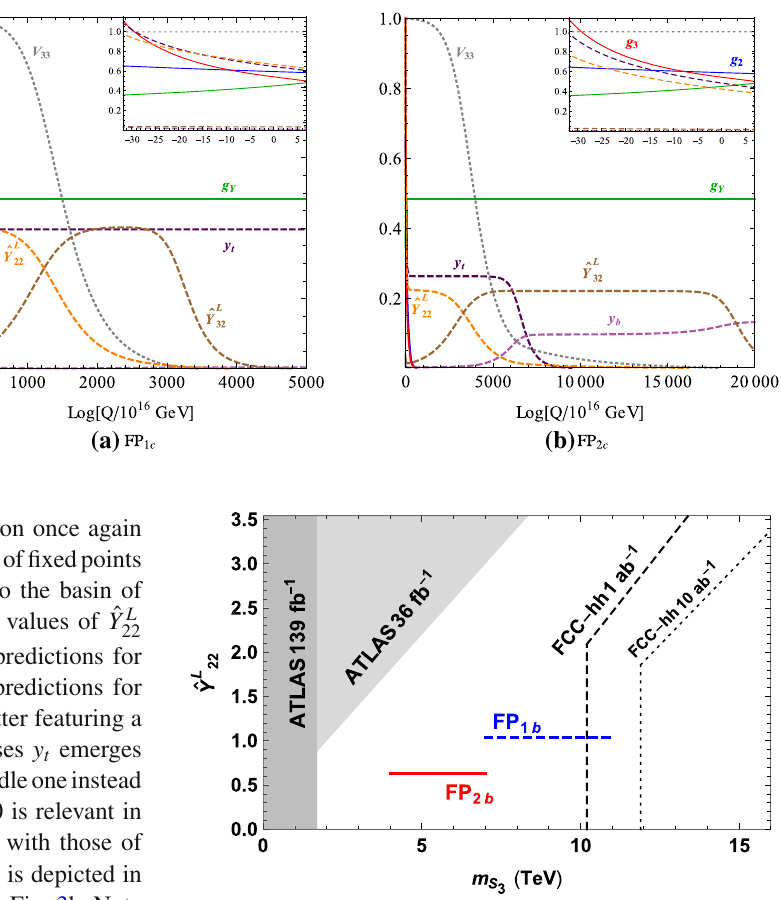
Fig. 4 The low-energy Yukawa coupling and mass ranges predicted by the trans-Planckian fixed-point analysis for the LQ S 3 to be in 2 σ agreement with the b → s anomalies. In red solid the range for FP 2 b , in dashed blue the range for FP 1 b . Dark gray region shows the current lower bound from color LQ pair-production at ATLAS [103], light gray region gives the bound from single quark production as recast in Ref. [101]. The dashed (dotted) black line marks the estimated reach of the √ s = 100TeV and 1ab − 1 (10ab − 1 ) hadron-hadron collider FCC-hh at integrated luminosity [104]